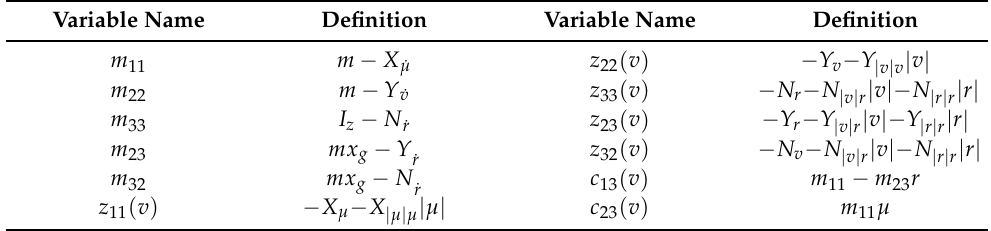
Table 1. The parameters of the M , C , and Z